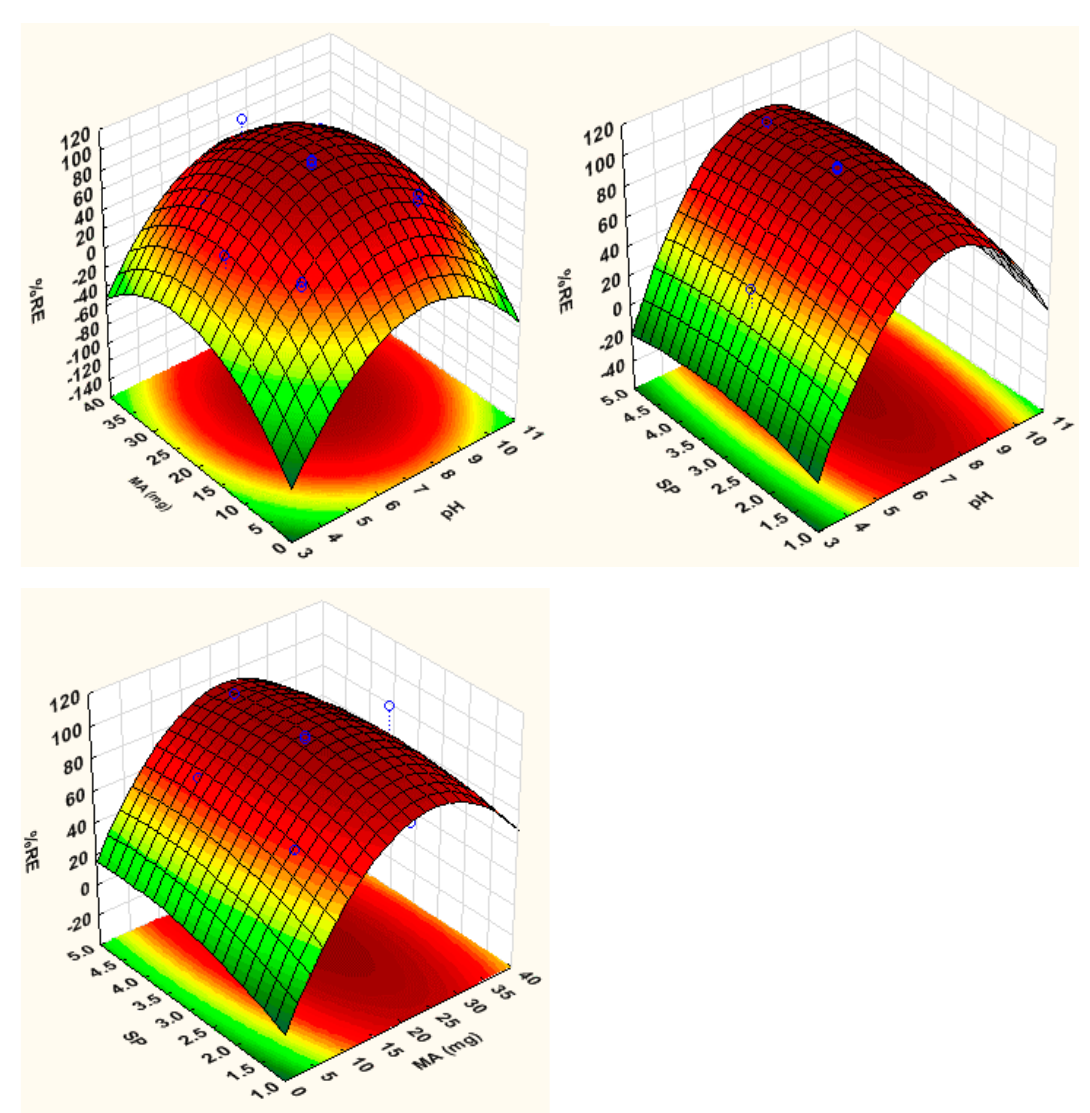
Figure A1. The 3D surface response plots describing the interactions of investigated parameters (ENRO).